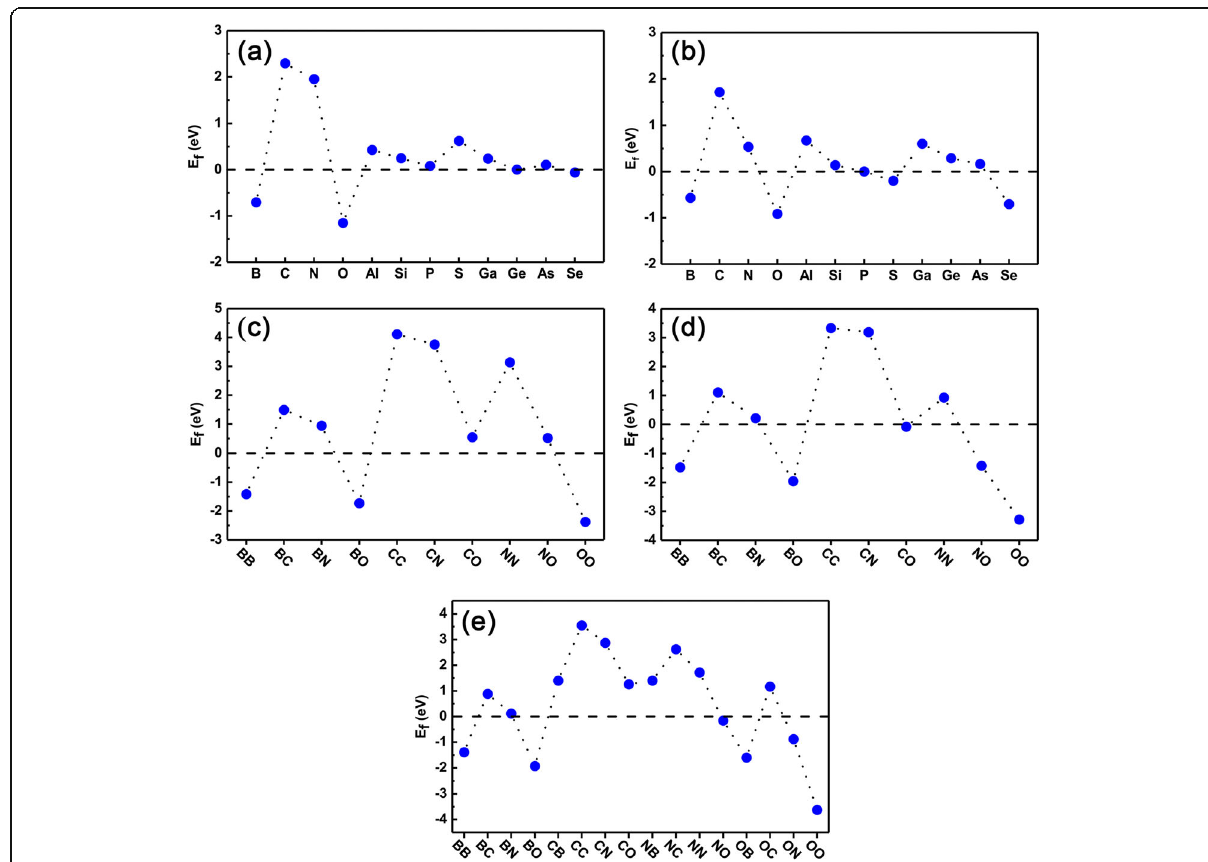
Fig. 8 Formation energy of all doped systems. The calculated formation energy of single element doping and co-doping systems. a , b are the dopant-substituted Ge atom and P atom, respectively; c – e The co-dopants substituted by two Ge atoms, two P atoms, and one Ge atom and one P atom,